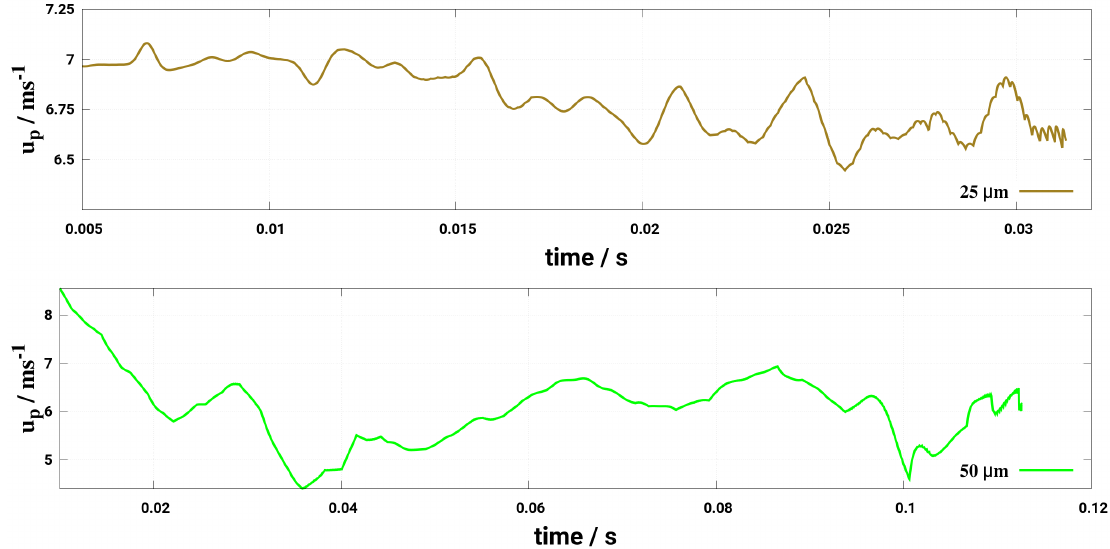
Figure 12. Evolution of the instantaneous velocity of the droplets during its lifetime: for mass flow rate ˙ m g = 100 kg/h at gas temperatures of 573 K, examplarily d 0 = 25, 50 µ